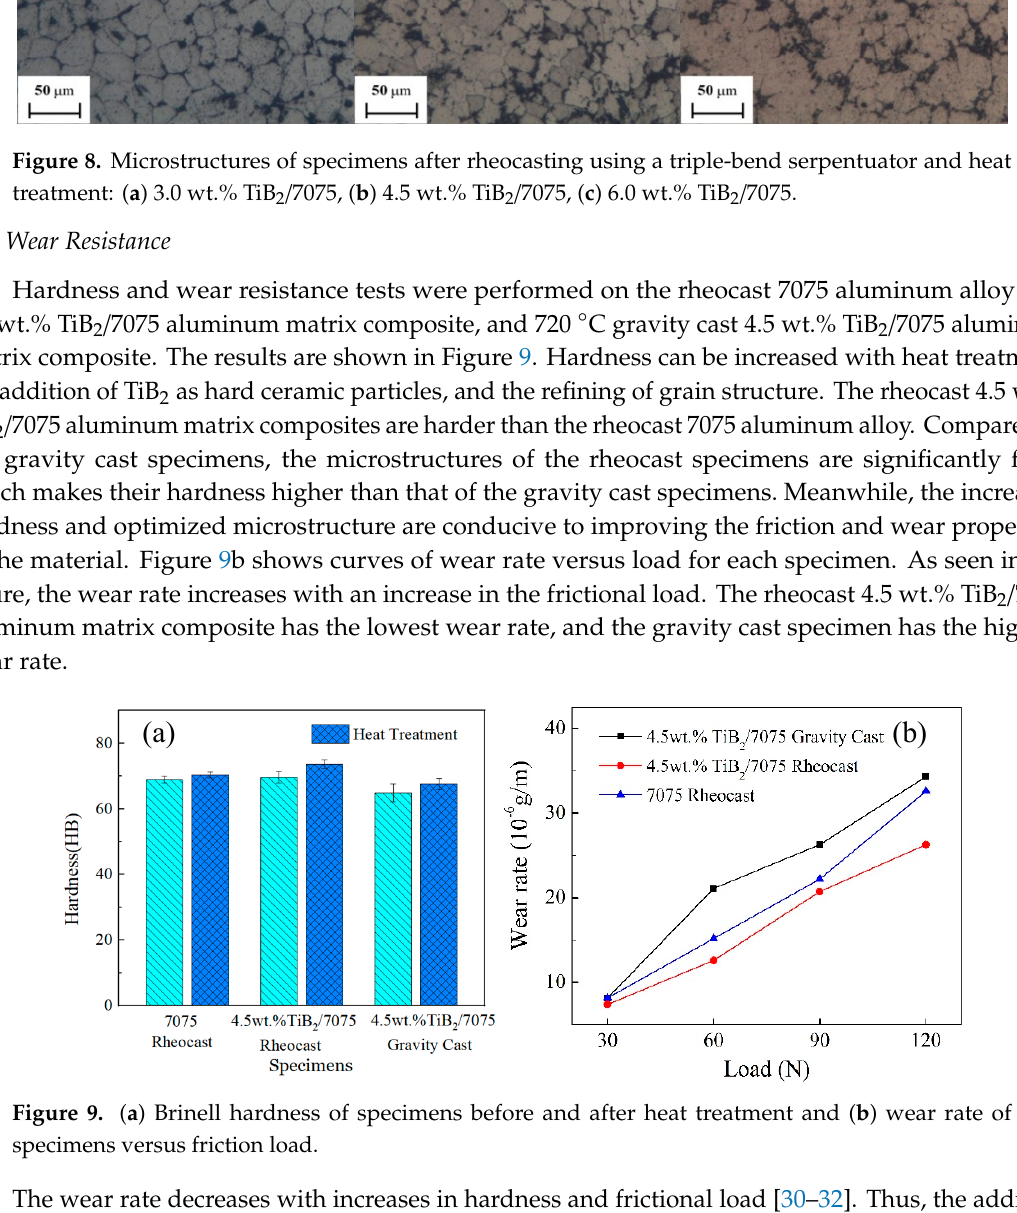
Figure 8. Microstructures of specimens after rheocasting using a triple-bend serpentuator and heat treatment: ( a ) 3.0 wt. % TiB 2 /7075, ( b ) 4.5 wt. % TiB 2 /7075, ( c ) 6.0 wt. % TiB 2 /7075.